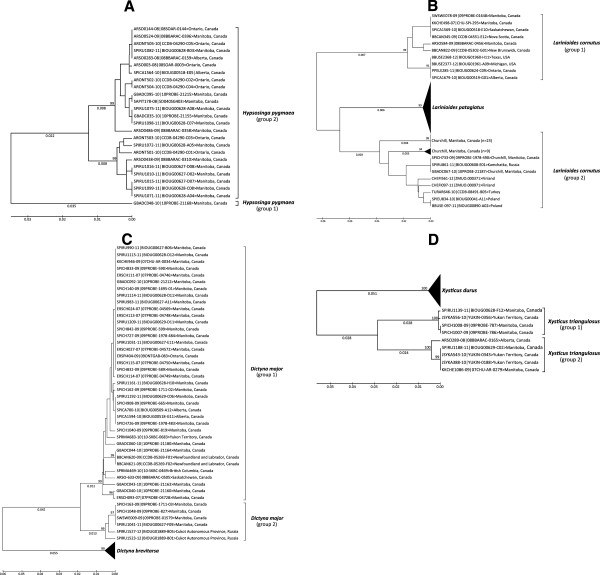
Ultrametric neighbour-joining trees (K2P) showing deep sequence divergence at COI in four species: A)Hypsosinga pygmaeahas two haplotype groups with 6.2% minimum divergence; B)Larinioides cornutushas two haplotype groups with 5.9% divergence and that are paraphyletic with respect toL. patagiatus;C)Dictyna majorhas two haplotype groups with 4.1% divergence; D)Xysticus triangulosushas two haplotype groups with 5.7% divergence. Bootstrap values are based on 500 replications.